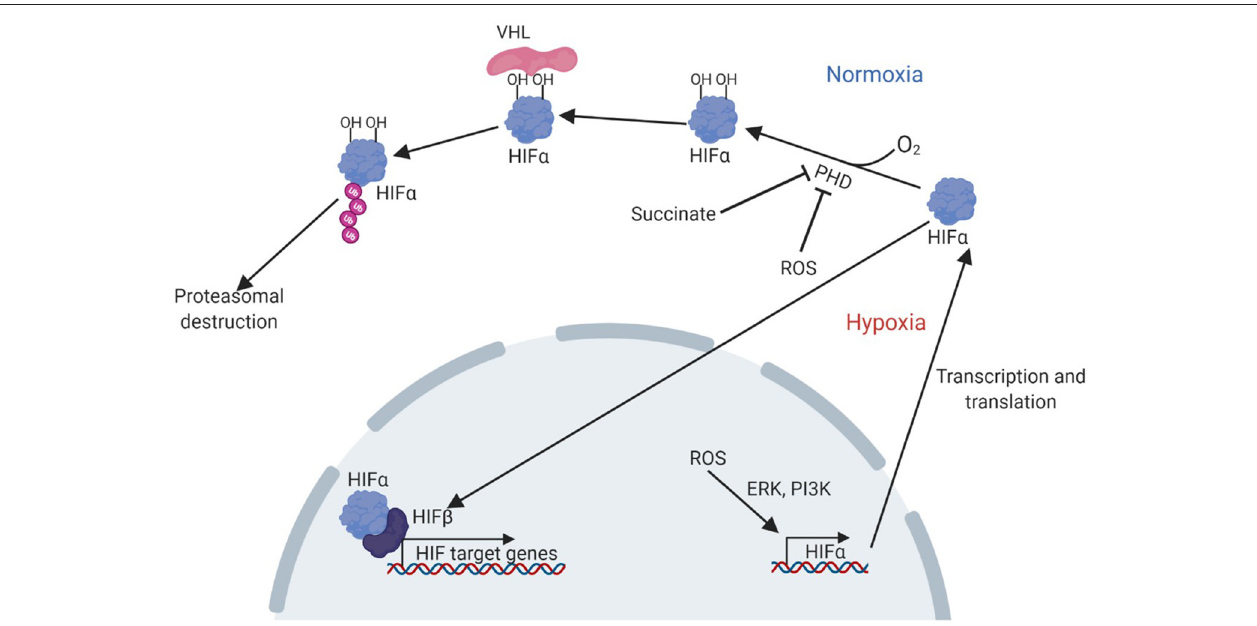
FIGURE 1 | Pathway of HIF activation in hypoxia. Adapted from Lee et al. (7). Under normoxic conditions, PHD enzymes hydroxylate proline residues in the HIF α subunit, in an oxygen-dependent manner. The hydroxylated residues are bound by VHL, which ubiquitinates HIF α allowing recognition and destruction of HIF α by the proteasome. Under hypoxic conditions, hydroxylation cannot occur and HIF α can instead translocate to the nucleus, bind HIF β and other cofactors to activate transcription of target genes. HIF accumulation can also result from PHD inhibition by succinate or ROS, or by increased transcription and translation due to a ROS induced, ERK and PI3K mediated pathway. ERK, extracellular-signal related kinase; HIF, hypoxia-inducible factor; PHD, prolyl hydroxylase domain proteins; PI3K, phosphoinositide 3-kinase; VHL, Von Hippel Lindau